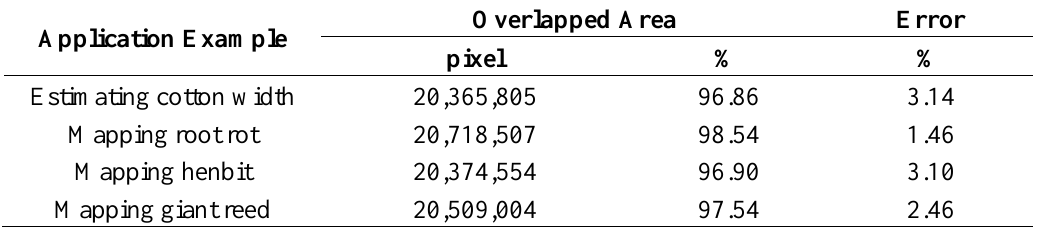
Table 5. Overlapped area and error for aligned near-infrared band images and normal color images for four different study